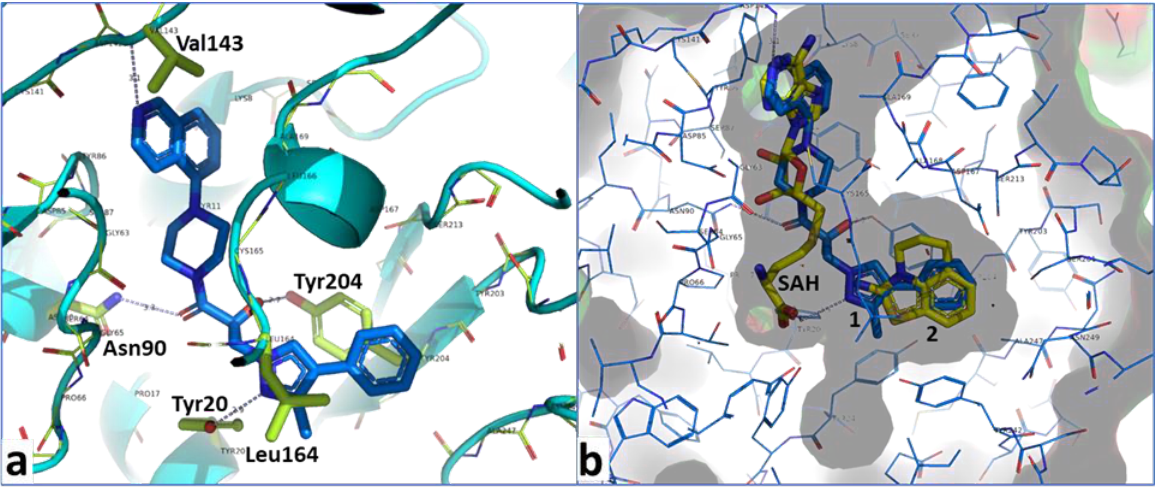
Figure 6. ( a ) Crystal structure showing the interactions of compound 1 (blue) with hNNMT. ( b ) Comparison with the binding mode of SAH (yellow), ( 1 ) (blue) and ( 2 ) (yellow) in the ( 2 ) complex. The surface of the protein is shown in grey. In the bottom-center, a large cavity is visible, below the Nam binding site.